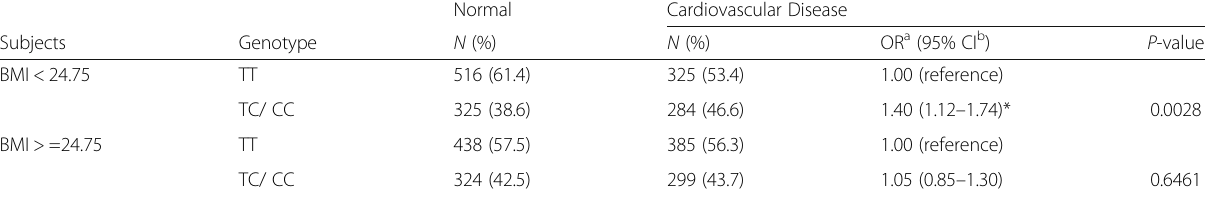
Table 5 Odds ratios (OR) of polymorphic rs17782313 MC4R genotypes for cardiovascular disease in Korean men ( n = 2896)